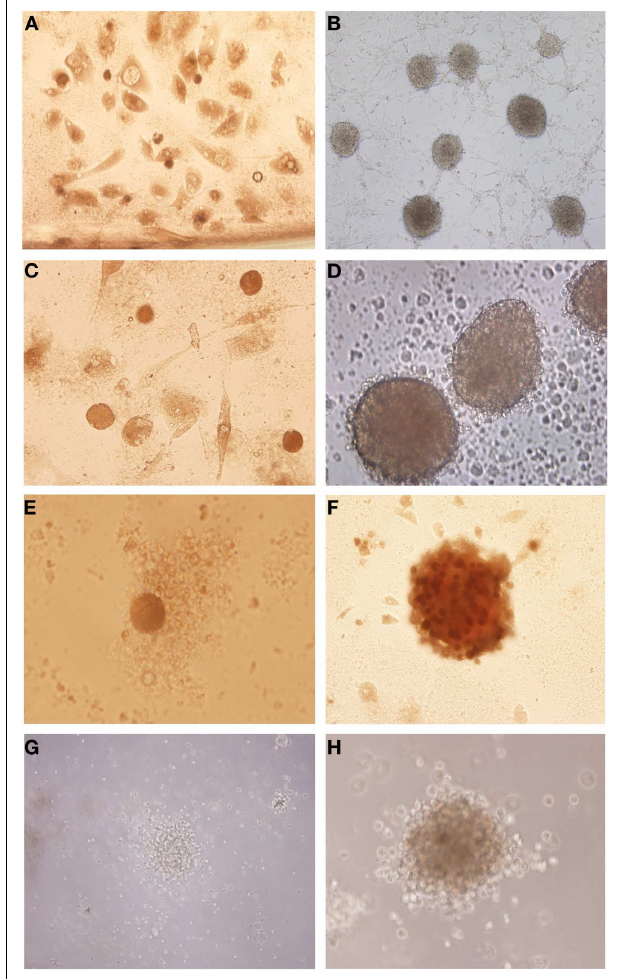
FIGURE 1 | Establishment of primary cell culture of human glioblastoma samples: immunocytochemical staining and transmission electron microscopy (TEM) of CD133 + cells glioblastoma . (A) Analysis of primary culture of glioblastoma. (B,C) Immunolocalization of CD133 + cells by immunocytochemical staining. (E) Immunolocalization of CD133 + cells immunofluorescence assays (G,H) Immunolocalization of CD133 + cells by transmission electron microscopy and that arrows indicate electron-dense nanoparticles in the glioblastoma cell surface recognizing the CD133 epitope. (D,F) Glioblastoma cells from control group of immunocytochemical and immunofluorescence techniques, respectively. Representative figure of five samples of glioblastoma. (A) Magnification 400 × . (B–F) Magnification 600 × . Scale bars: (G,H) 0.25 µ m. cells populations separation efficiency, the CD133 + fraction was stained with CD133/2PE and evaluated by flow cytometry FAC- SARIA (BD Biosciences, San Jose, CA, USA) and FACSDIVA